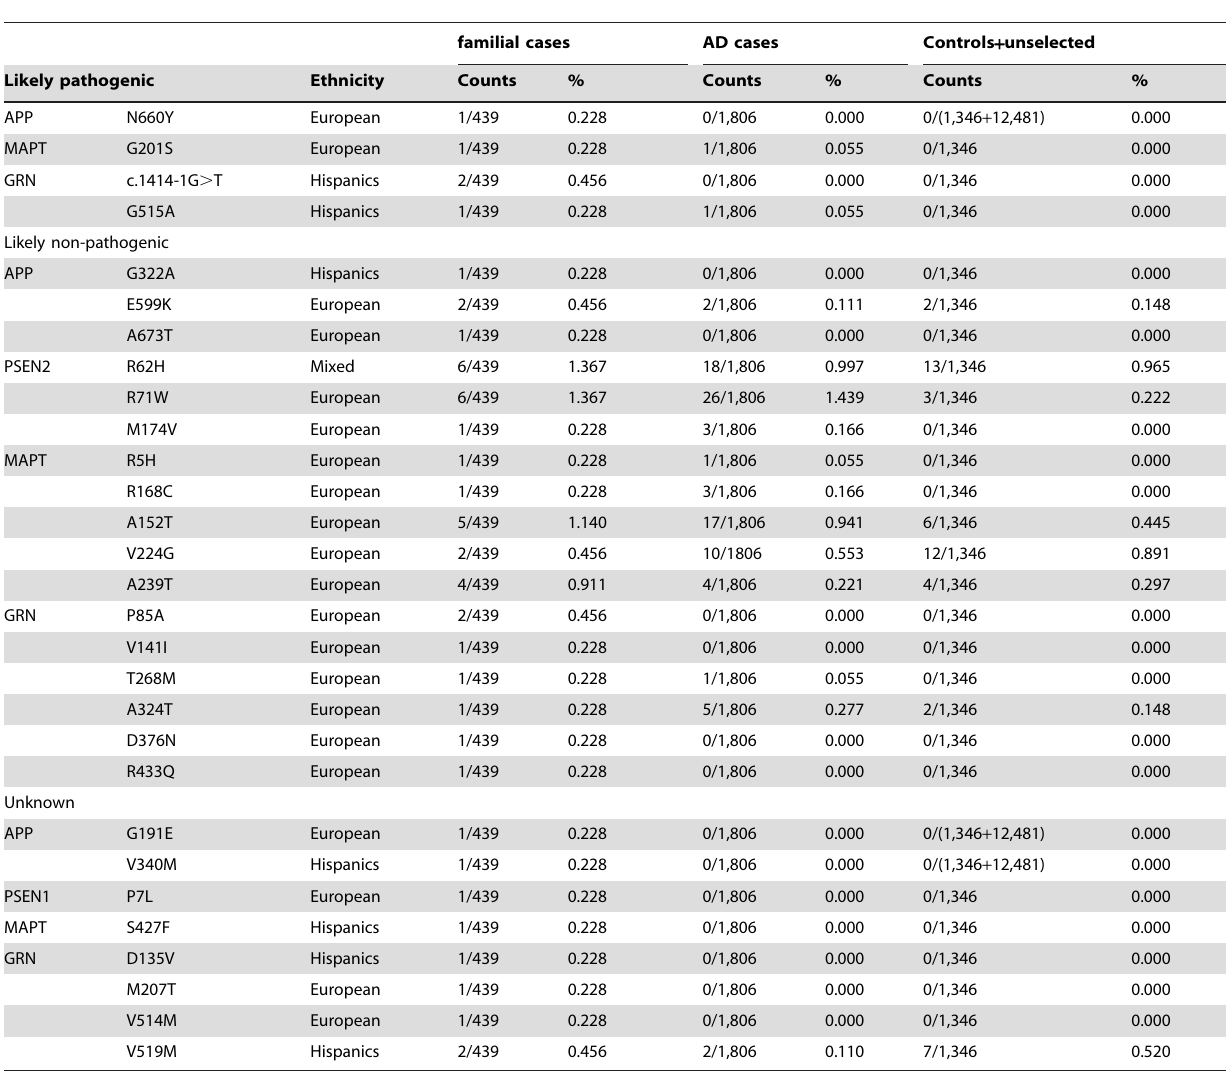
Table 5. Allele frequency of all variants in the initial dataset and in additional case-control